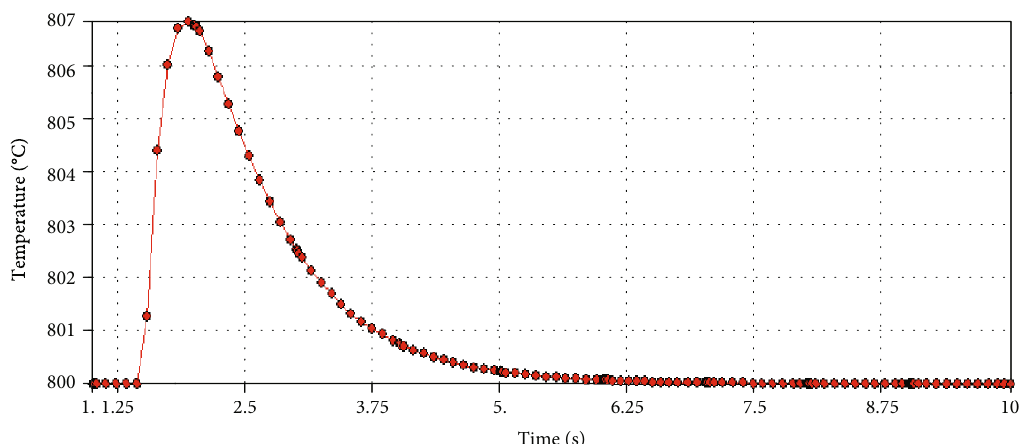
Figure 12: Global maximum temperature distribution over the mitad.